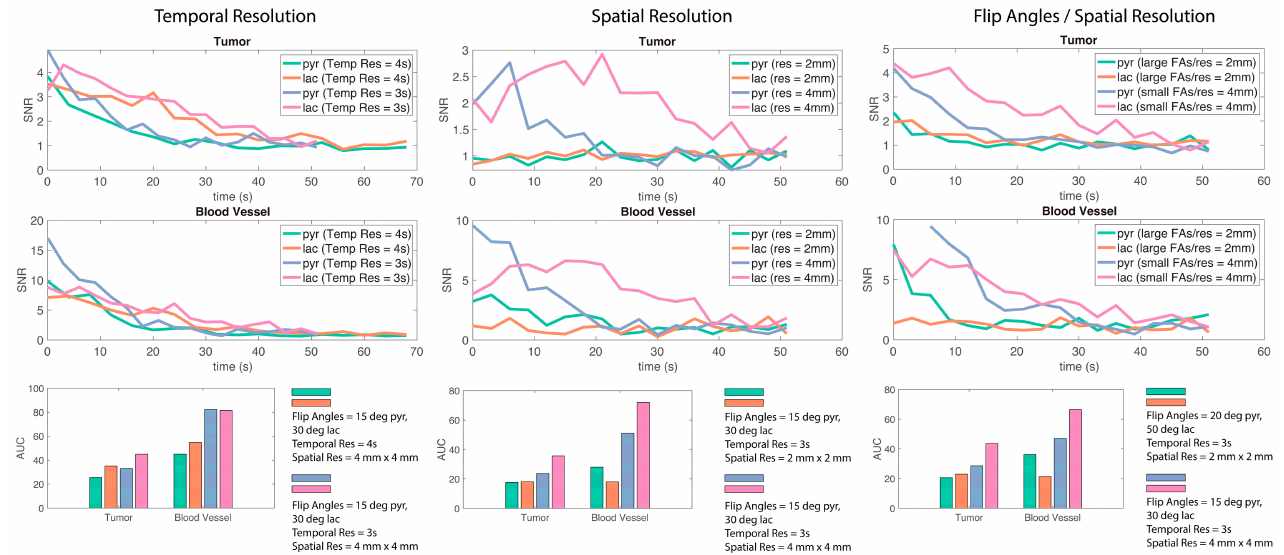
Figure 5. SNR over time and area-under-the-curve (AUC) values for various in vivo mice experiments. Shorter temporal resolution and coarser spatial resolution result in higher signal AUC. Tumor model and location from left to right: LuCap93 kidney; LTL kidney; and LTL